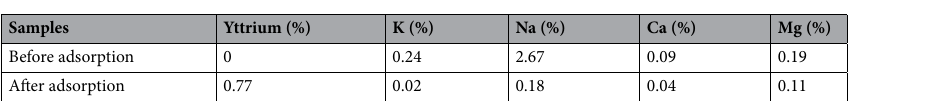
Table 4. EDS analysis of S. marcescens surface metallic element content before and after Y(III) biosorption.